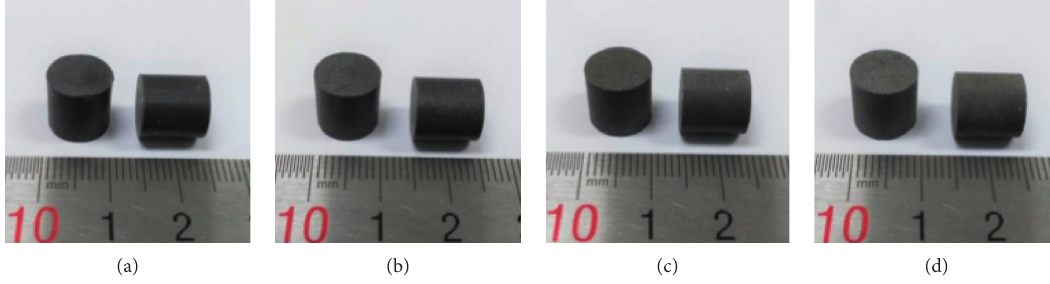
Figure 7: Dynamic compression samples: (a) 0% W. (b) 25% W. (c) 45% W. (d) 60%